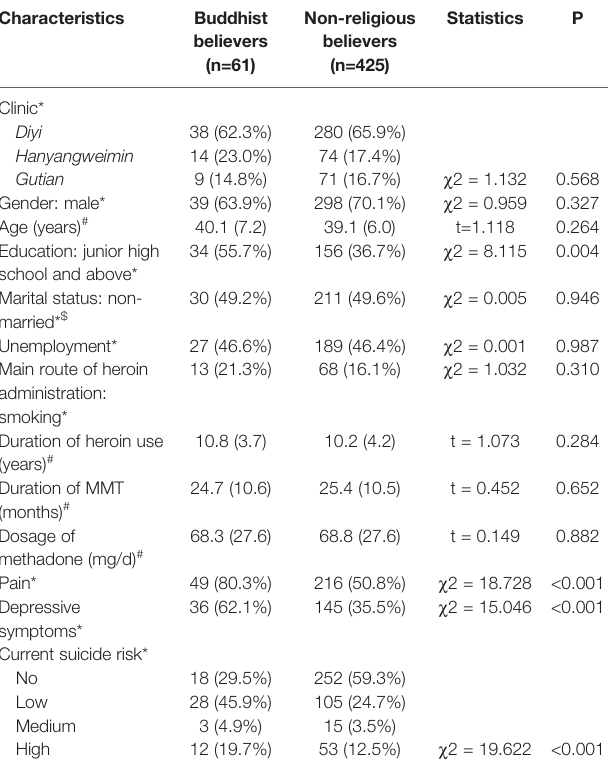
TABLE 2 | Multiple ordinal logistic regression on the association between Buddhist belief and current suicide risk in Chinese persons receiving methadone maintenance therapy for heroin dependence, controlling for demographic and clinical factors and depressive symptoms.